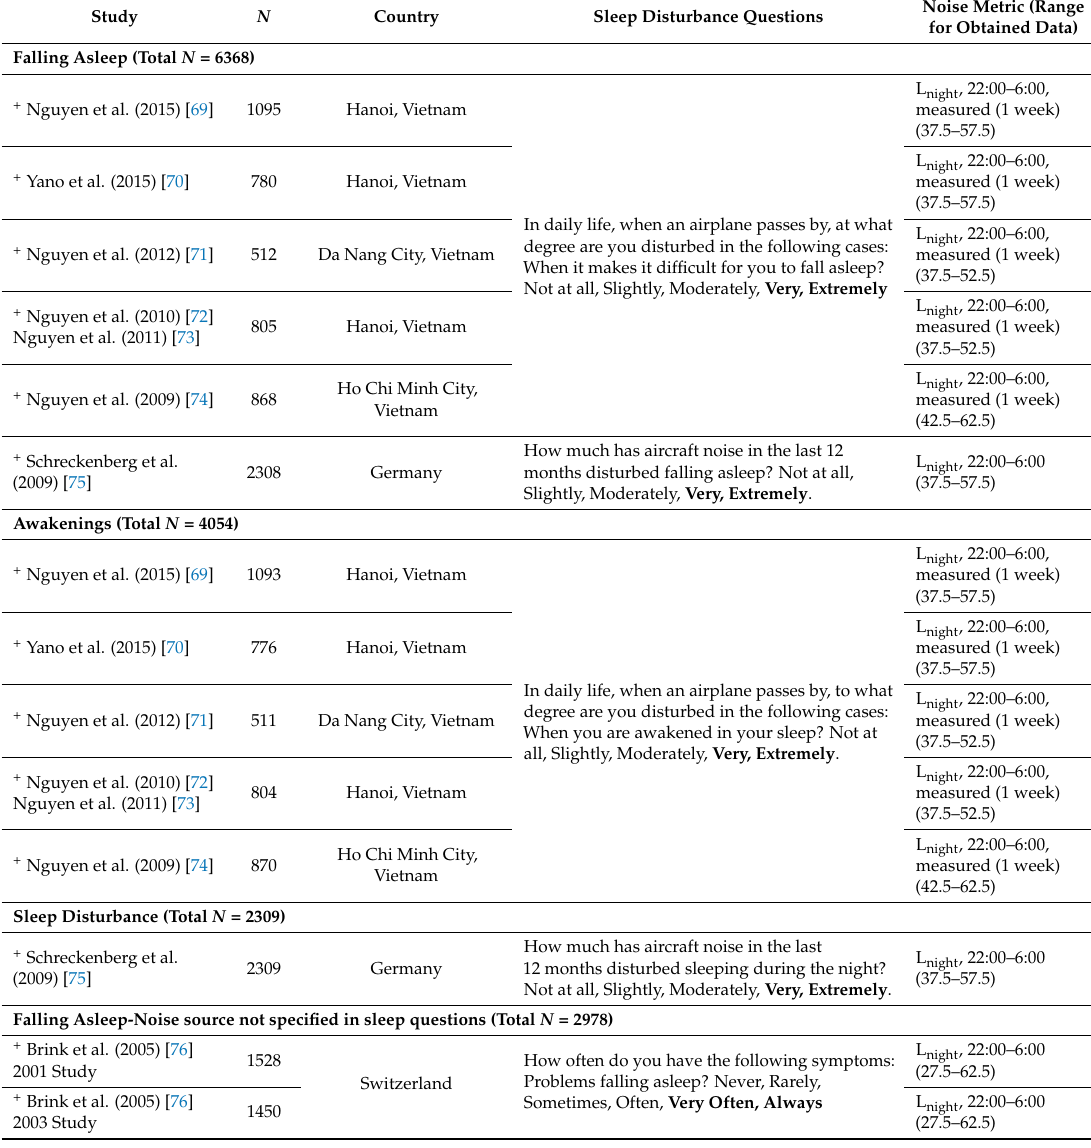
Table 2. Studies on aircraft noise and self-reported sleep disturbance (* general health survey, + noise survey). Studies modeled the noise levels except where indicated. Response alternatives contributing to the calculation of the percent Highly Sleep Disturbed are in bold.